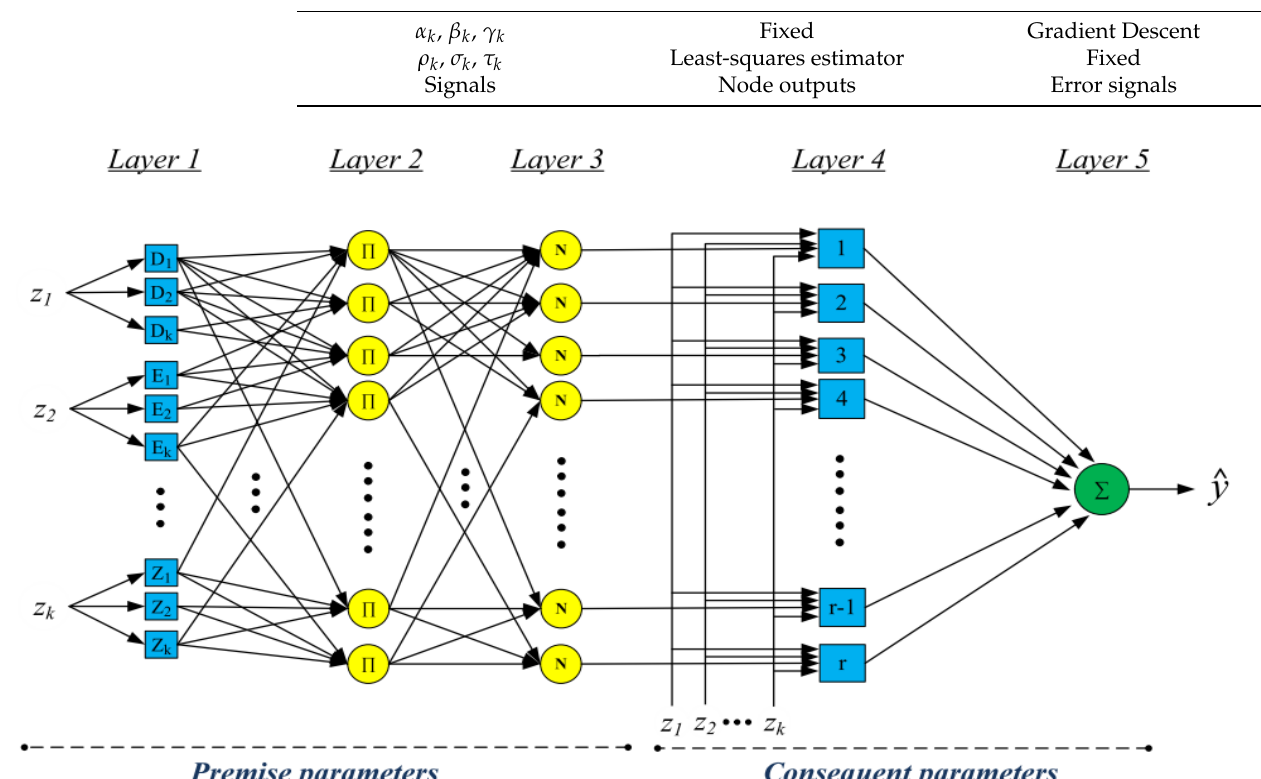
Figure 3. The proposed idea for ANFIS architecture. Table 1. The hybrid learning methodology for ANFIS.